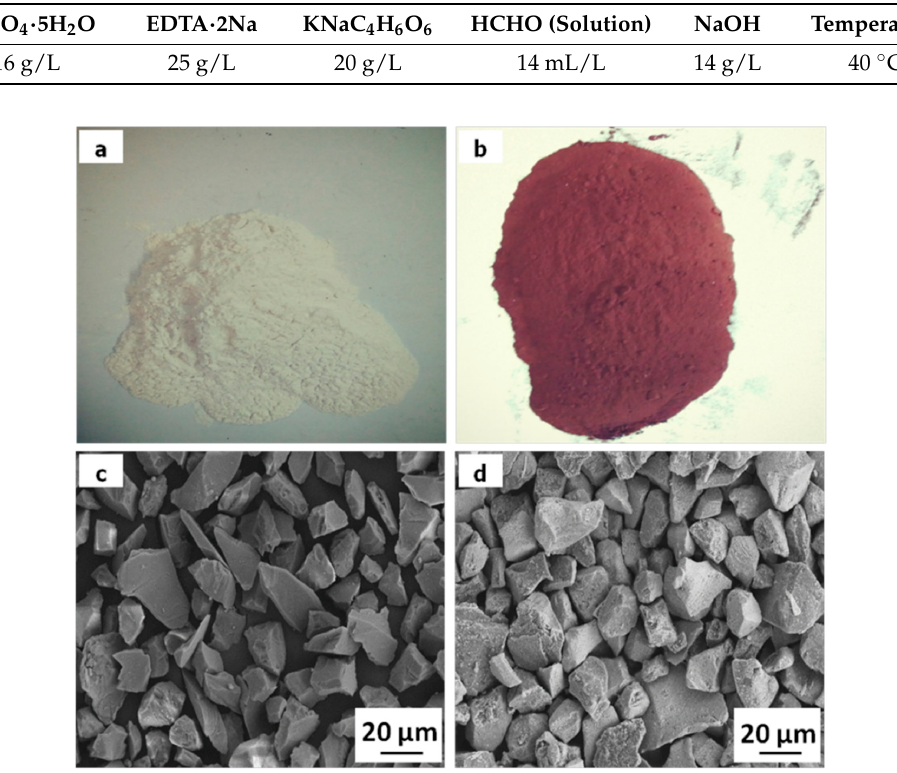
Table 1. Technology conditions of electroless copper coating.